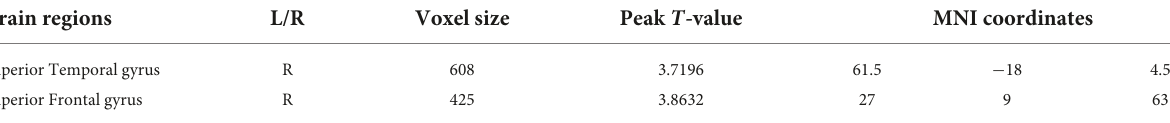
TABLE 4 Significant differences in GMVs in MDDs between pre- and post-ECT.